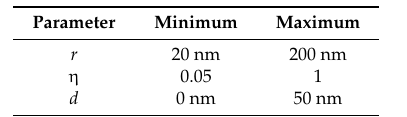
Table 1. Ranges of the geometrical parameters to be optimized.